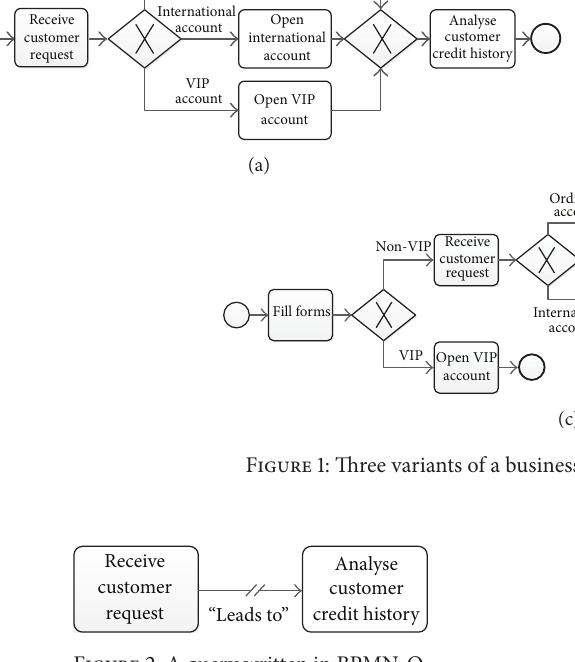
Figure 2: A query written in